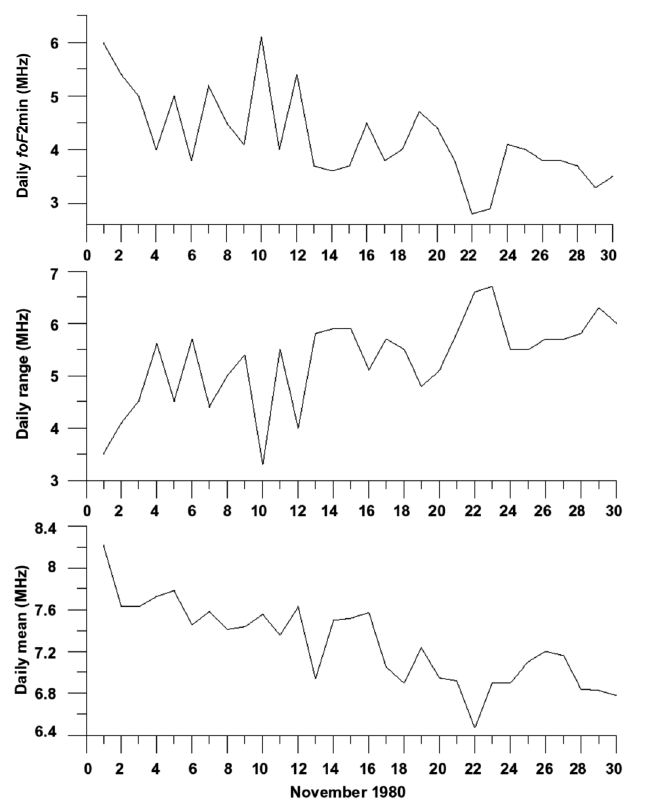
Fig. 11. From top to bottom: minimum daily values of the critical frequency, daily range of the critical frequen- cy variation, daily mean value of the critical frequency for November 1980 (Athens ionospheric